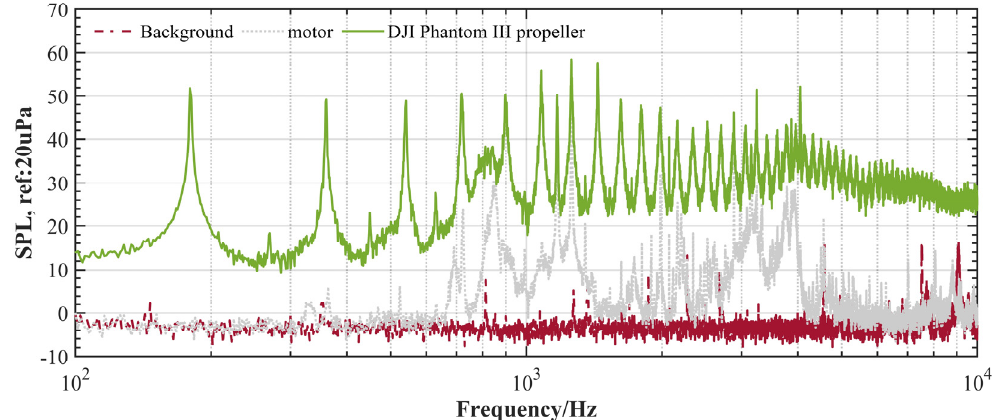
Figure 6. Comparison of the power spectral density of background noise, unloaded motor noise, and DJI Phantom III propeller (#5) ( 5400 𝑅𝑃𝑀, 𝜃 = 25 deg ).